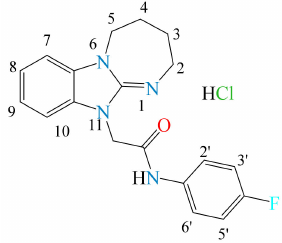
Figure 10. Compound 2b